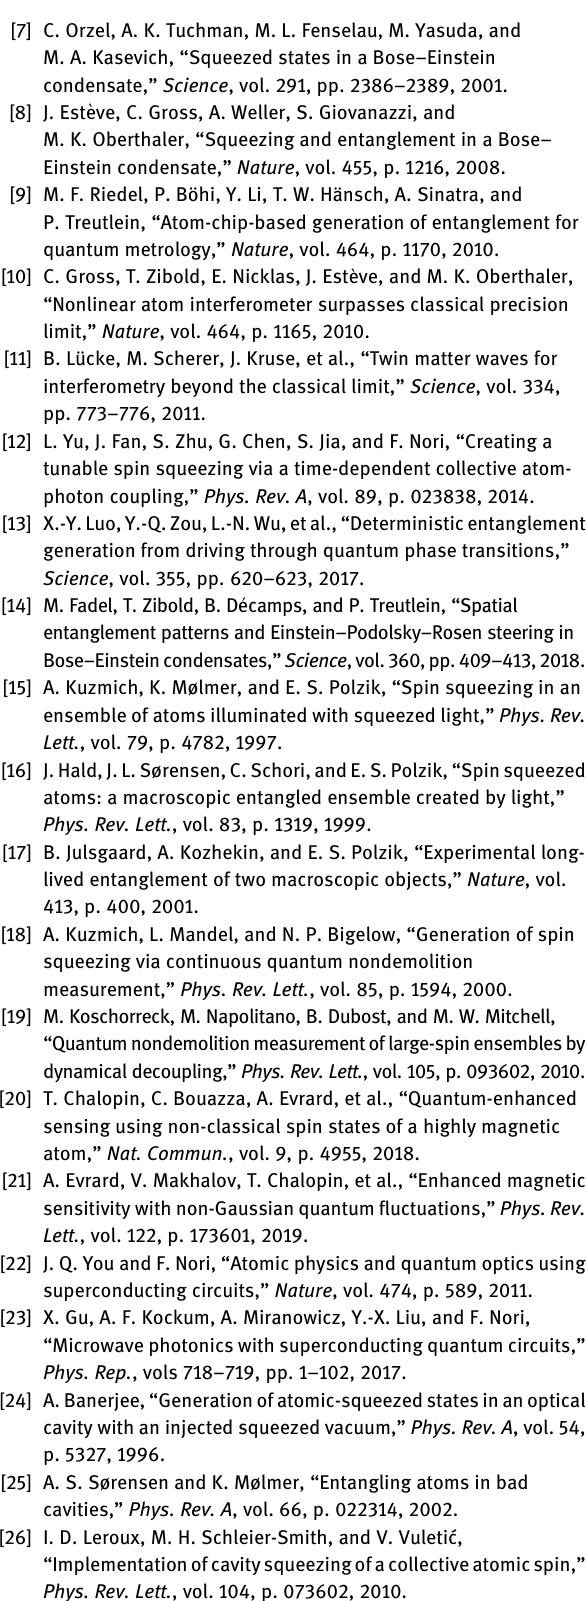
Table I, a spin-squeezed steady state of ≈− 12 dB can be achieved for a squeezing time ≈ 0.8 µs, or ≈− 20 dB for ≈ 8 µs. This justi fi es neglecting spin decoherence, which, as described above, could be made much slower. We also fi nd, according to an exponential squeezing given in Eq. (C11), that by properly increasing γ , we can achieve a c shorter squeezing